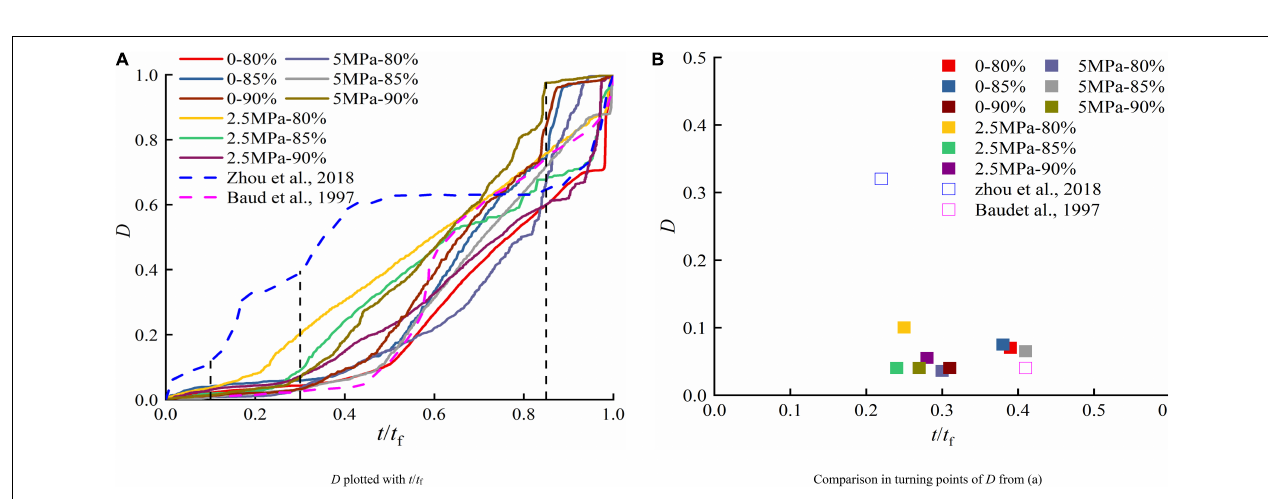
FIGURE 11 | Damage variable characteristics with t / t f . (A) D plotted with t / t f . (B) Comparison in turning points of D from panel (A) .